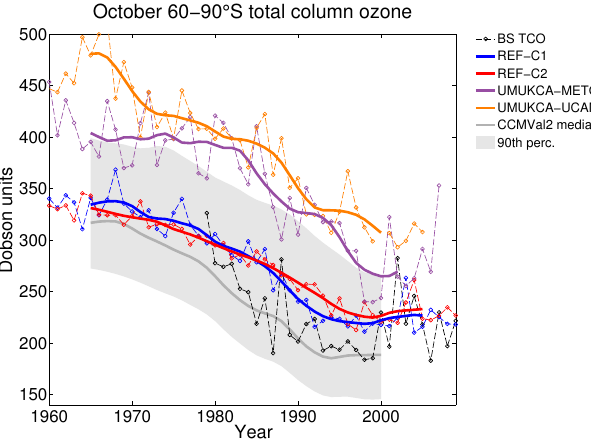
Figure 2. Time series of REF-C1 and REF-C2 TCO averaged be- tween 60 and 90 ◦ S compared with the Bodeker Scientific total column ozone database observations, the UMUKCA-UCAM and UMUKCA-METO models and the CCMVal-2 ensemble. Dashed lines show the October average, while solid lines have undergone a 10-year-running mean of October averages. The shaded region shows 10th and 90th percentiles of the CCMVal-2